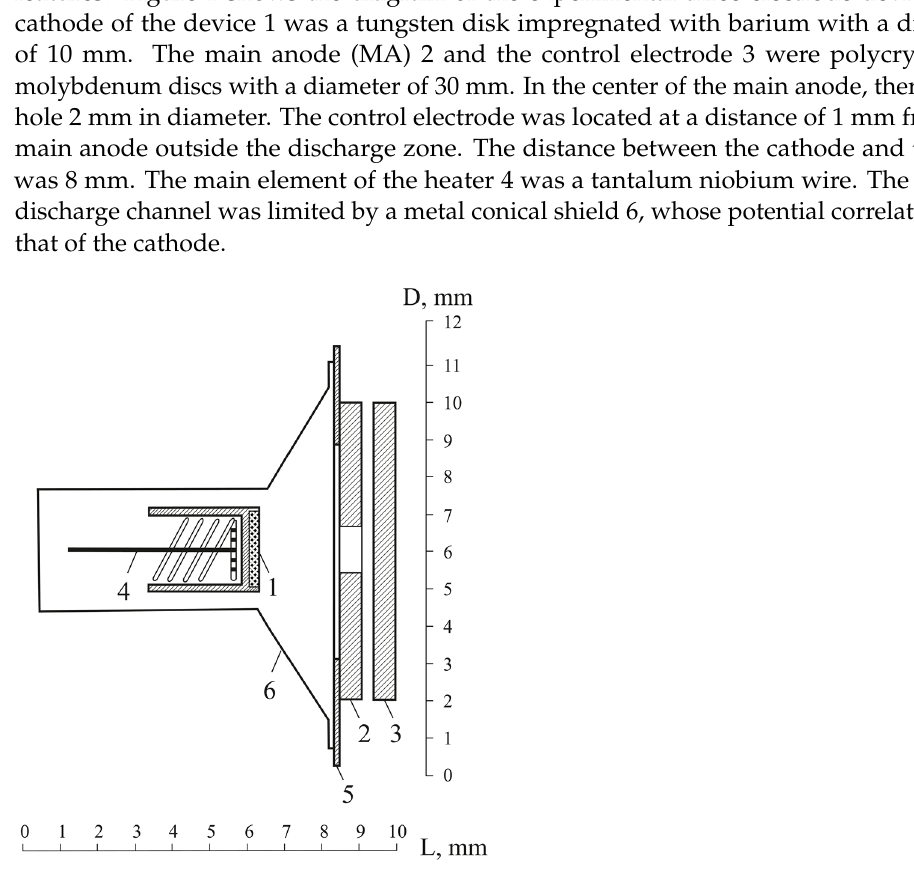
Figure 1. The device with a narrowed discharge channel: cathode (1), main anode (2), external con- trol electrode (3), heater (4), alundum insulators (5), and conductive shield (6). electrode (3), heater (4), alundum insulators (5), and conductive shield